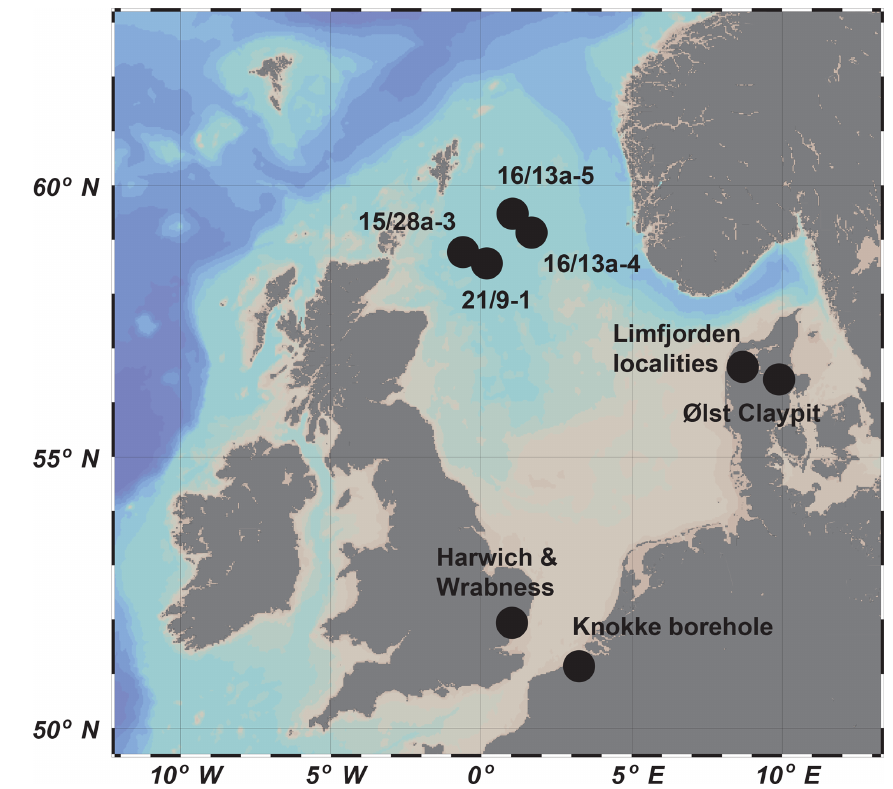
Figure 1. Sample localities in and around the North Sea